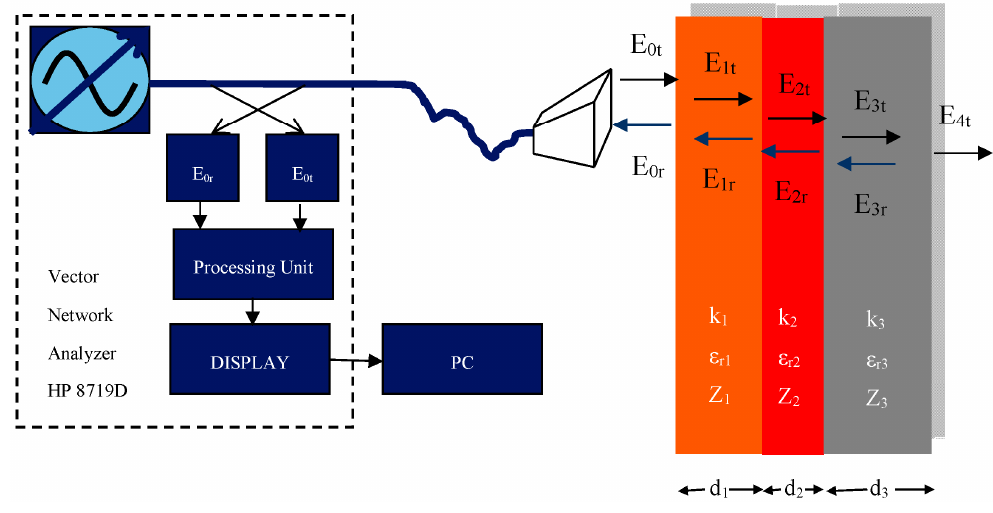
Figure 1. Experimental setup for the measurement of the reflection coefficient.